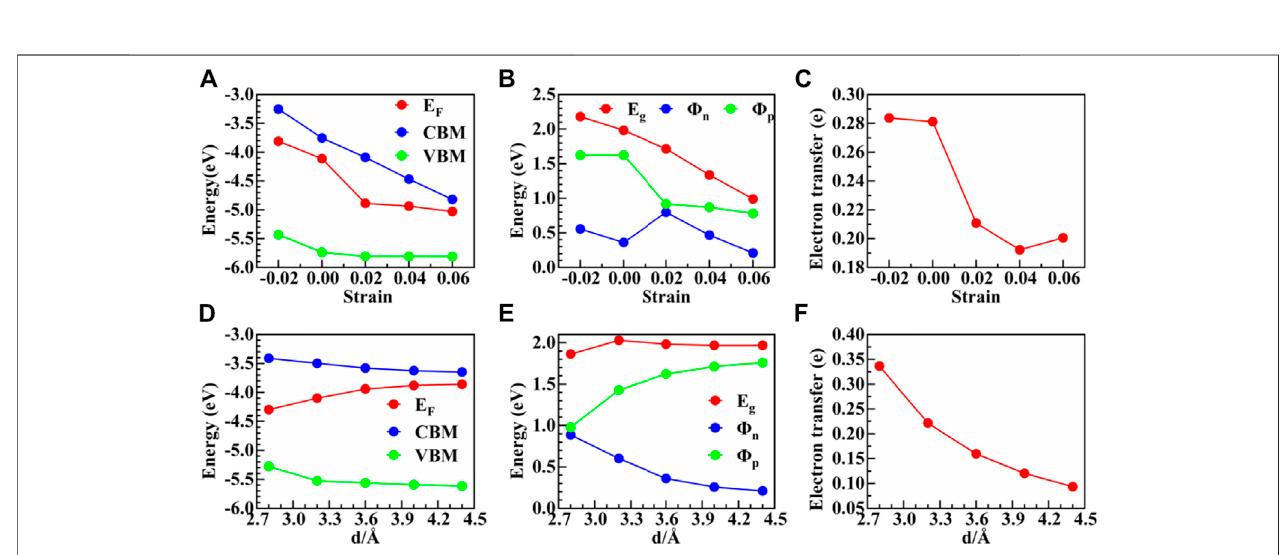
Frontiers in Chemistry |